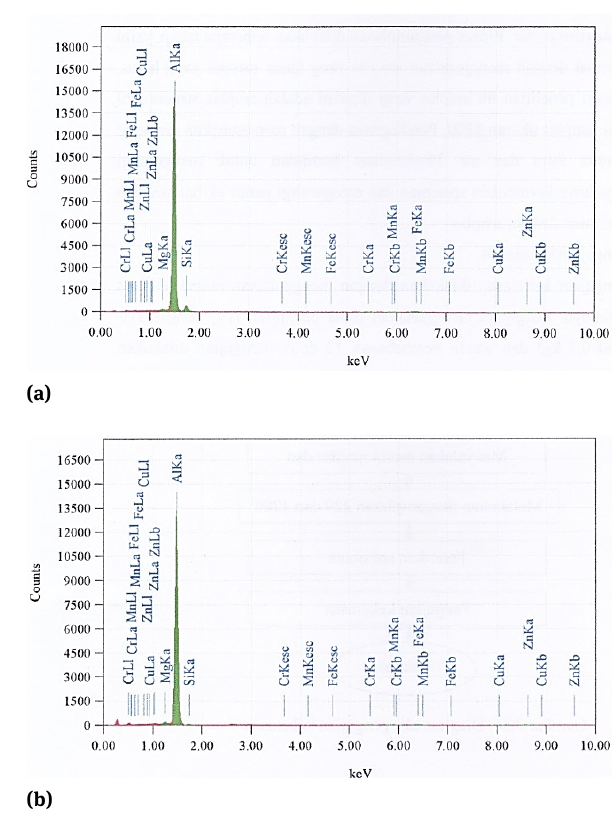
Figure 1: The energy-dispersive x-ray spectroscopy (EDS) results of AL6061 (a) BM; and (b)